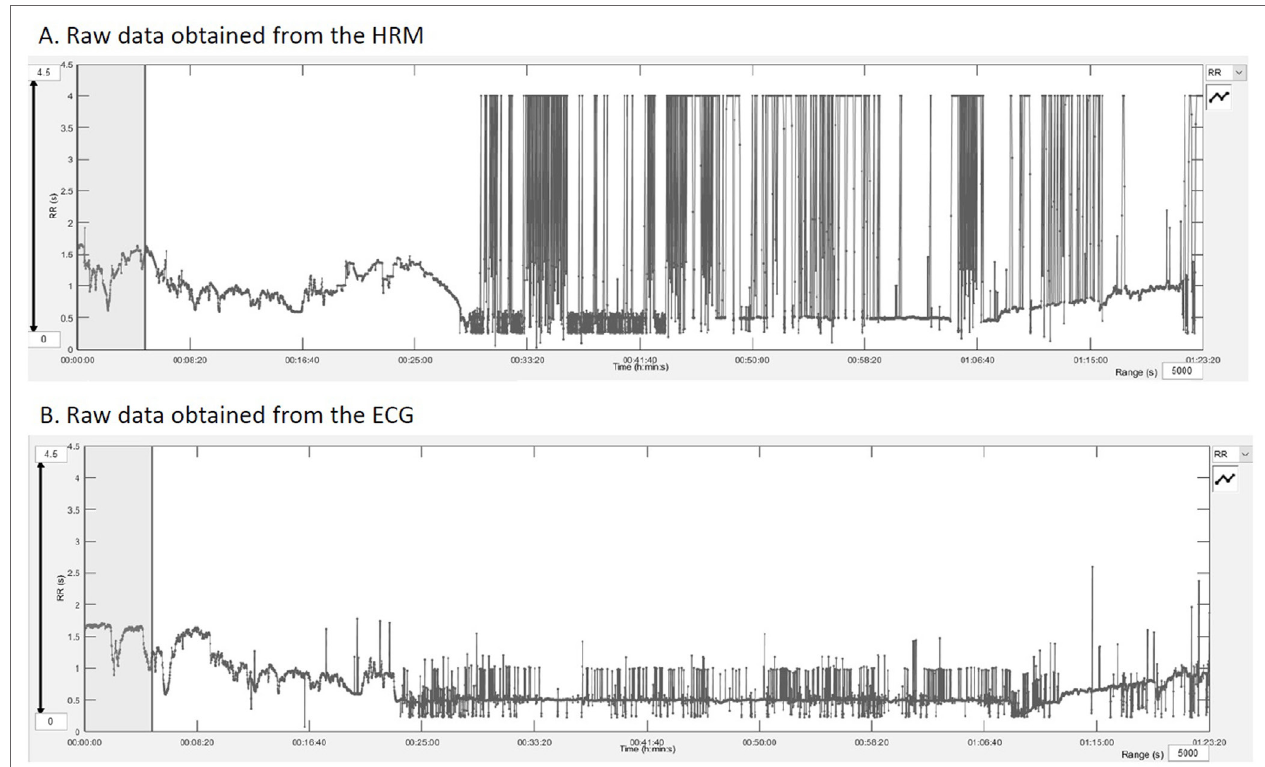
FigUre 2 | RR intervals outputs obtained after downloading the raw data into the Kubios HRV ® software showing the quality of the raw data and the extent of artifacts. (a) RR intervals in seconds registered by the HRM over the entire exercise test. (B) Represents the same data from the electrocardiogram